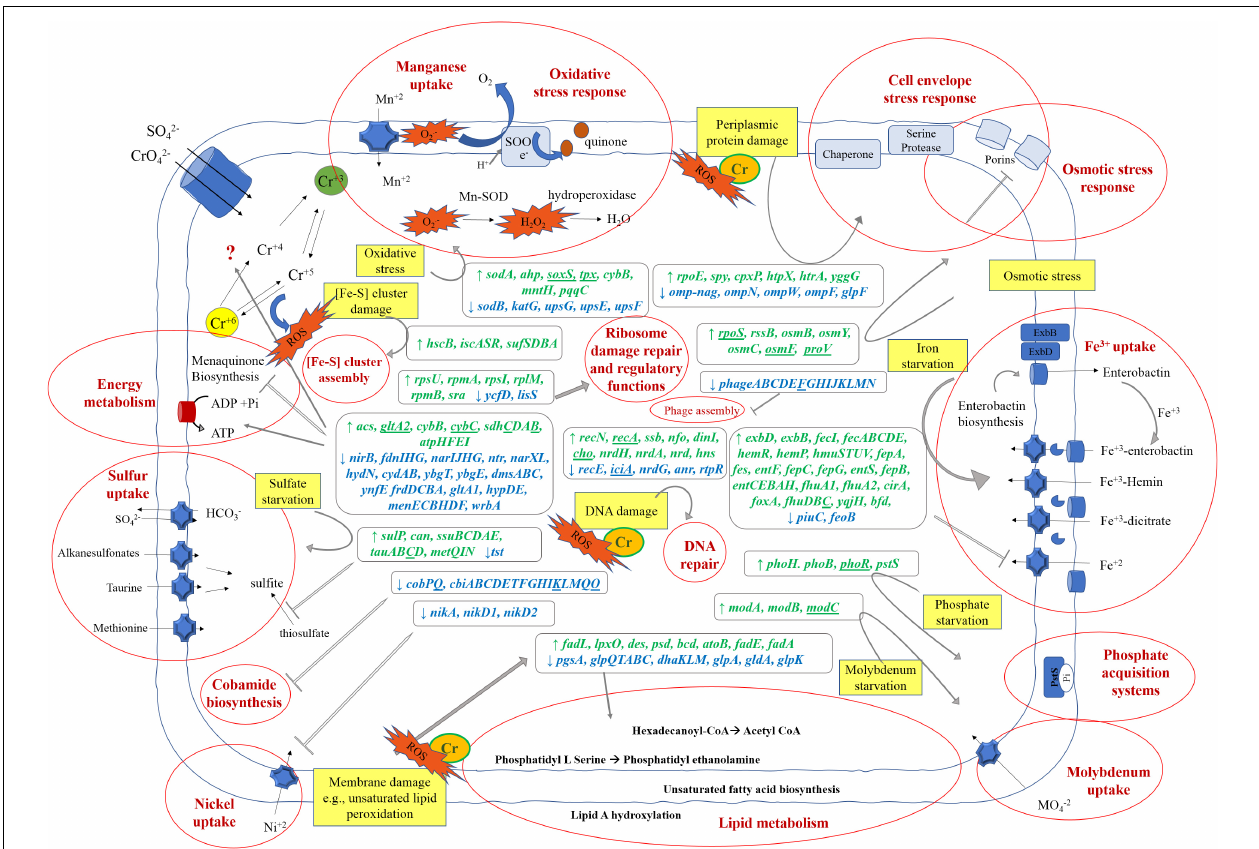
FIGURE 7 | Schematic model of Klebsiella sp. strain AqSCr metabolic adaptation to 11 mM Cr(VI). Stress pathways elicited by Cr(VI) (yellow squares) and metabolic responses (written in red bold inside red circles) associated to the upregulated (green) and downregulated genes (blue) in the presence of Cr(VI) are highlighted. Gene abbreviations correspond to those in Supplementary Tables 5, 6 . Genes underlines are those that were found to be differentially transcribed but outside of the cutoff